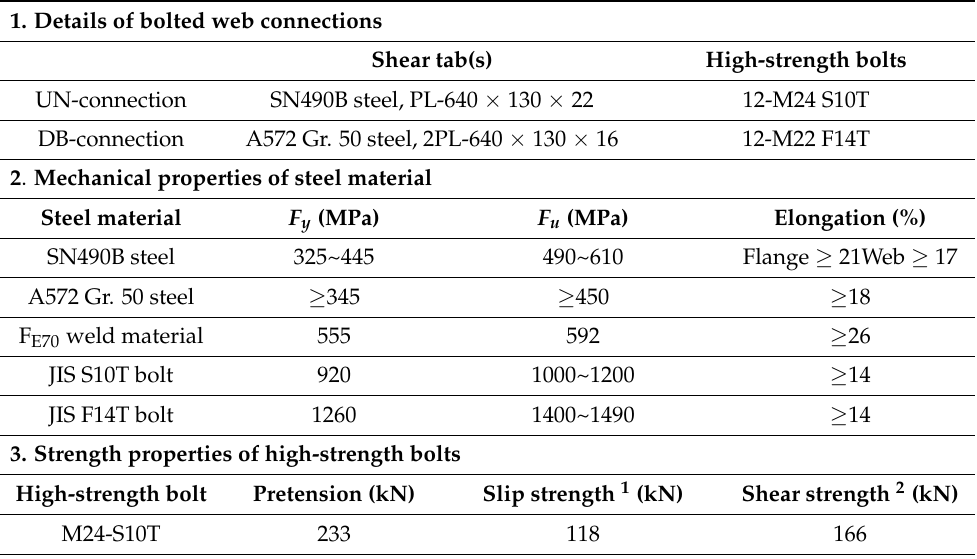
Table 1. Details of bolted web connections and mechanical properties of steel